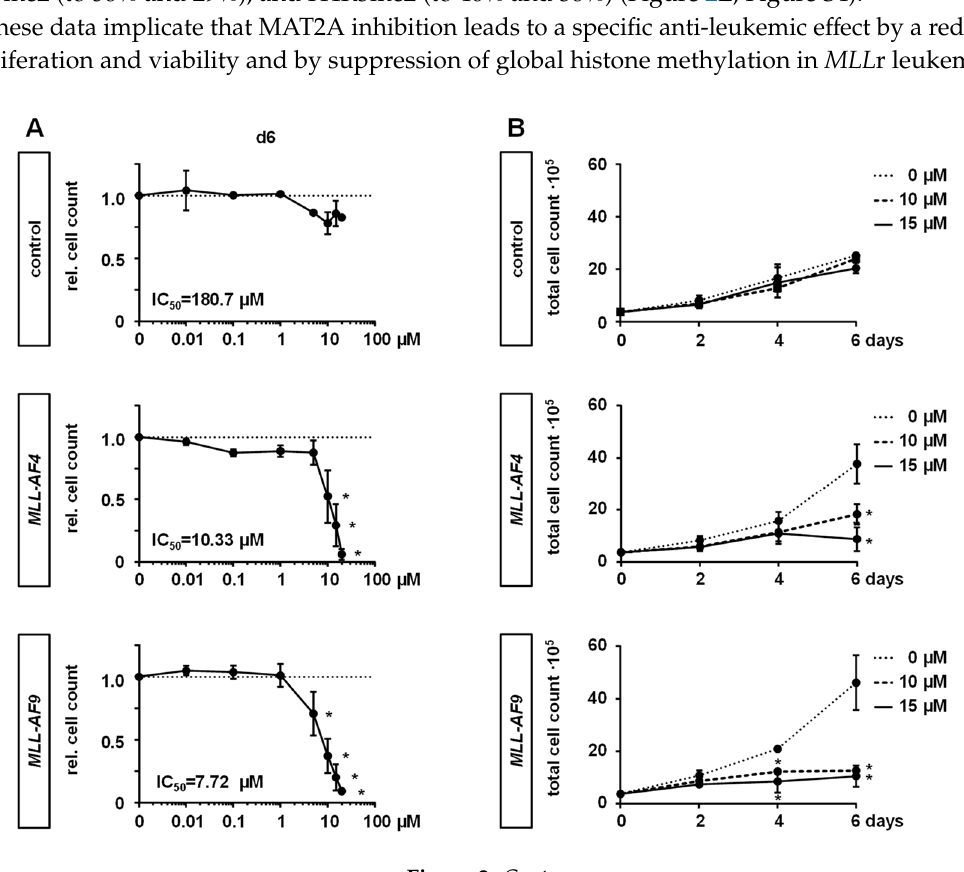
Figure 2. MAT2A inhibition impairs the proliferation and viability of MLL r cells, resulting in reduced SAM levels and histone methylation. ( A ) MLL-AF4/-AF9 or culture-expanded CD34 + huCB control cells were treated with increasing concentrations of PF-9366 or vehicle (DMSO) for 6 days and the relative cell count was determined by flow cytometry using counting beads. Pooled data of three biological replicates ( n = 3) performed in technical triplicates are shown. IC 50 values of the dose– response curves were interpolated from a four-parameter logistic model constrained to 0 and 1 in